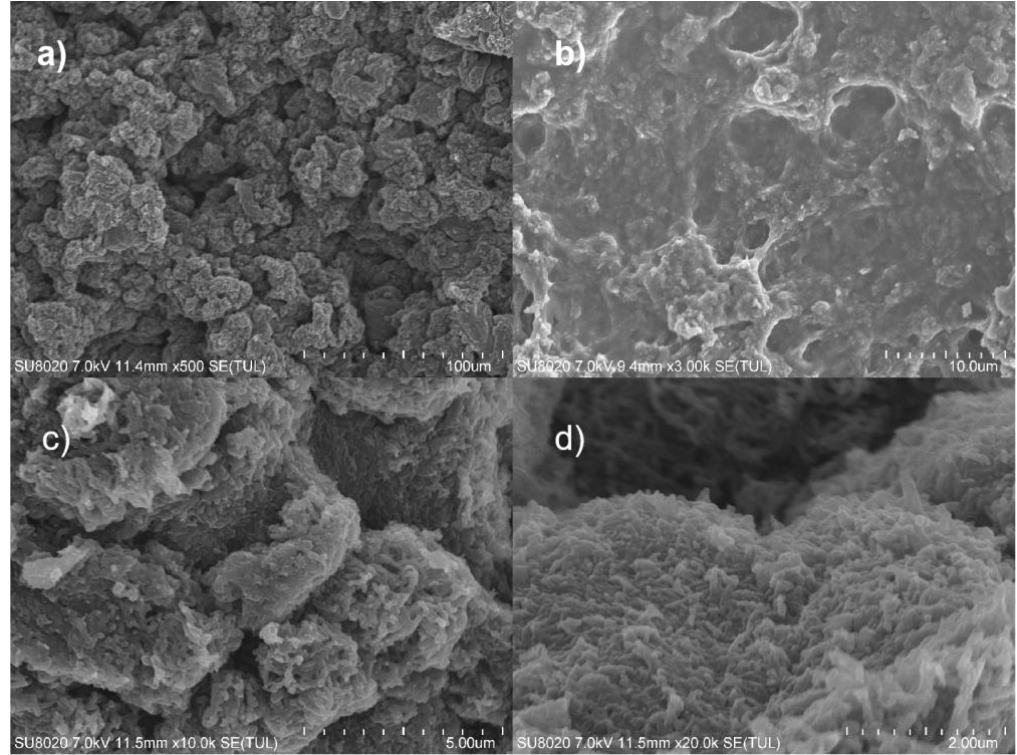
Figure 5. SEM images of PPy/CNCs ( a ) 500×; ( b ) 3000×; ( c ) 10,000×; ( d ) 20,000×. The AFM technology was used to observe the particle size and morphology of CNC, PPy and PPy/CNCs composites at the molecular level. The AFM image of CNC is shown in the Figure 6a. The length of CNC is about 200 nm, and the outer diameter is about 20 nm. The R a value is 1.13 nm, and the maximum height R p value is 21.1 nm, which is consistent with the theoretical value of CNC [36]. PPy particles were formed by Py polymerization, and the R a value is 0.329 nm (see Figure 6c). The surface roughness of PPy particles is low, which is due to the small gap between the long chains of molecules [37]. An image of the PPy/CNCs is shown in the Figure 6e. Theoretically, PPy/CNCs composites are formed by stacking PPy wrapped on the surface of CNC, and the surface roughness should be between CNC and PPy. The R a value of PPy/CNCs is 0.631 nm, which is larger than PPy but smaller than CNC, and the actual value is consistent with the theory. In addition, the R p value of PPy/CNCs is 35.53 nm, which is larger than the sum of the R p values of CNC and PPy. This should be the formation of hydrogen bonds between PPy and CNC molecules, which increased the molecular spacing, resulting in a larger R p value of